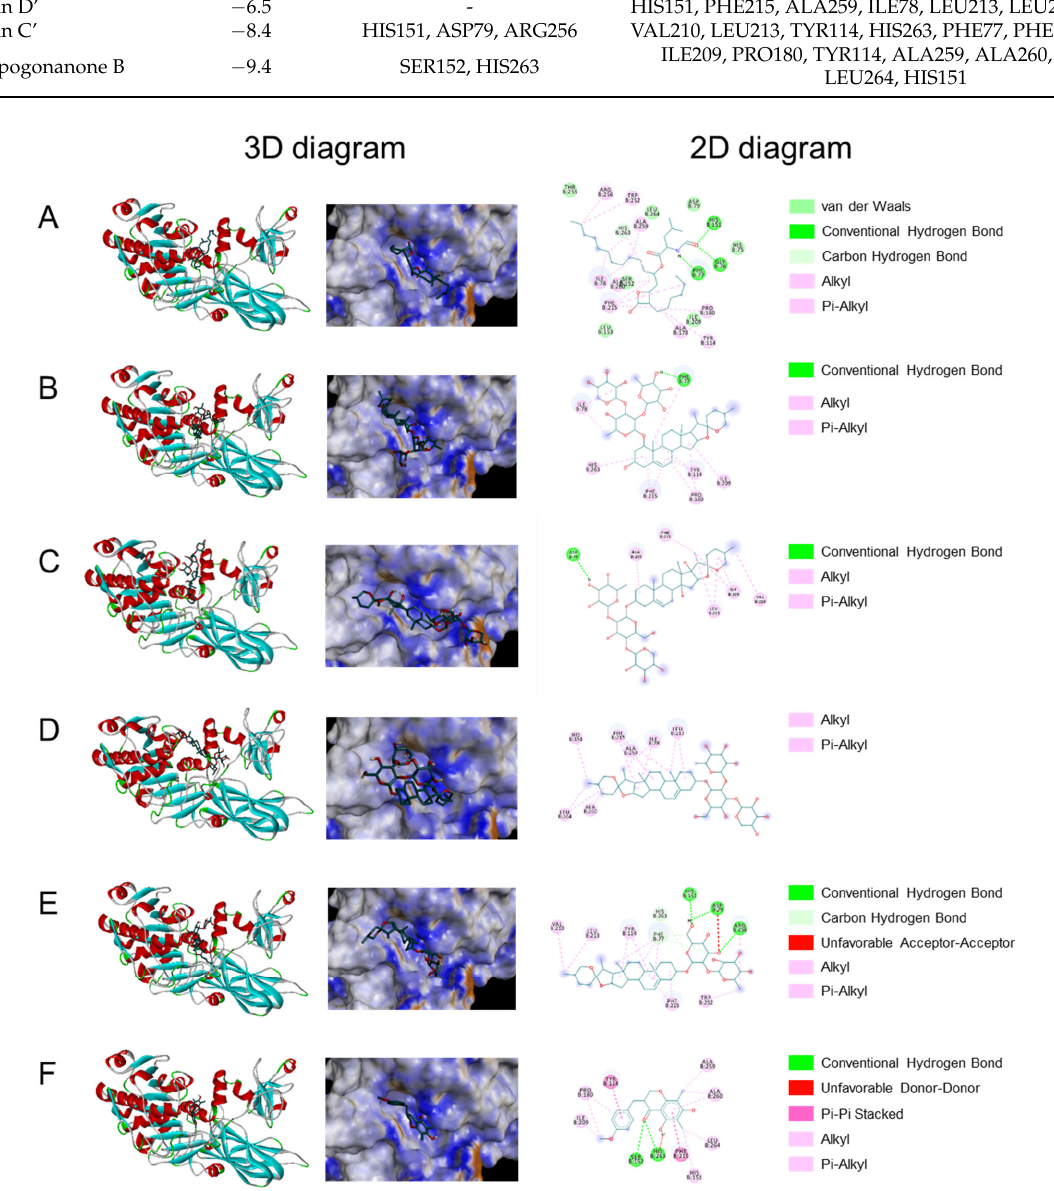
Figure 6. Binding modes and interactions between orlistat ( A ), ophiopogonin D ( B ), ophiopojaponin C ( C ), ophiopogonin D’ ( D ), ophiopogonin C’ ( E ), methylophiopogonanone B, ( F ) and pancreatic lipase.